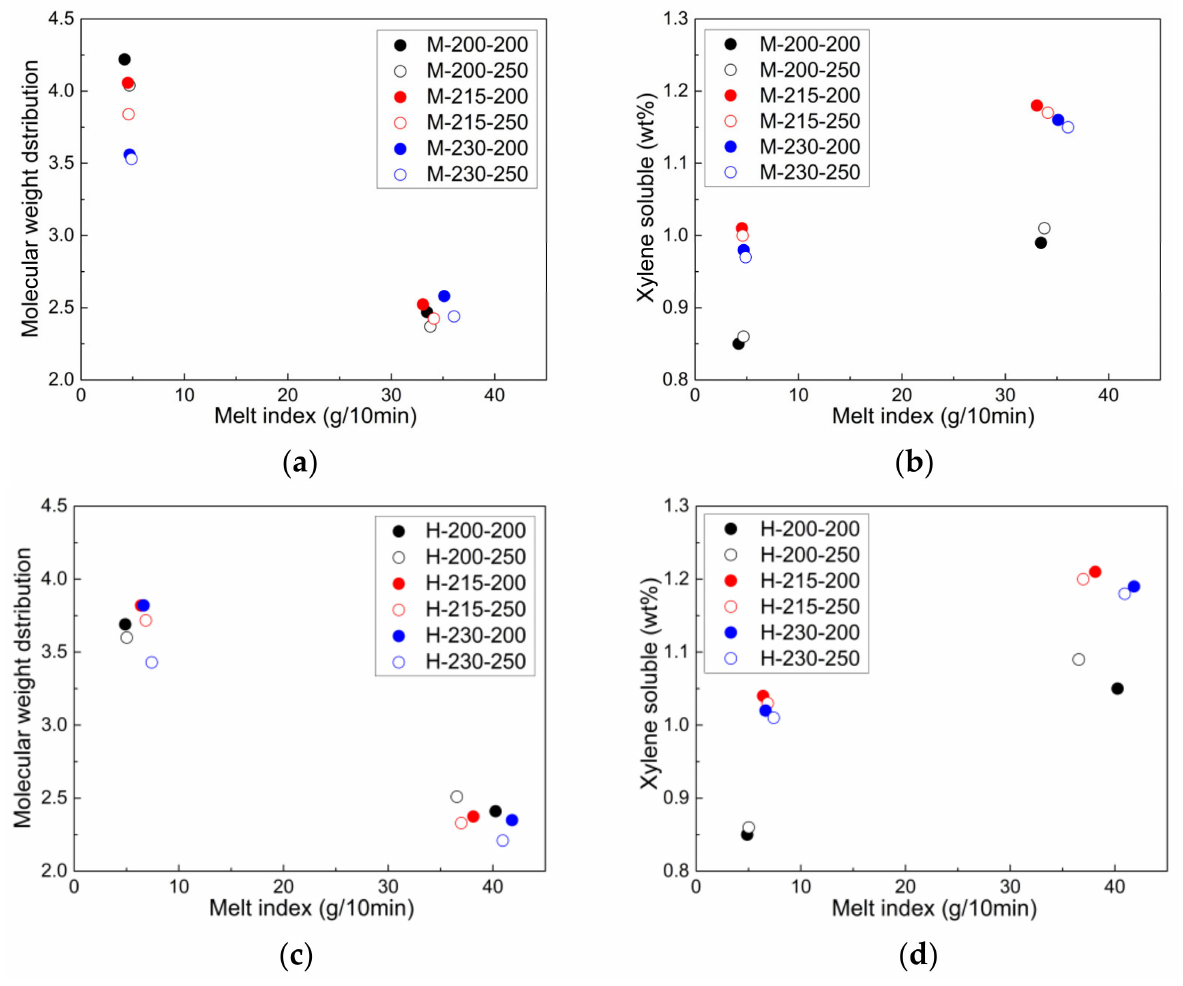
Figure 8. Relationship of ( a , c ) molecular weight distribution and ( b , d ) xylene-soluble property with respect to melt index of CR-PPs under various extrusion